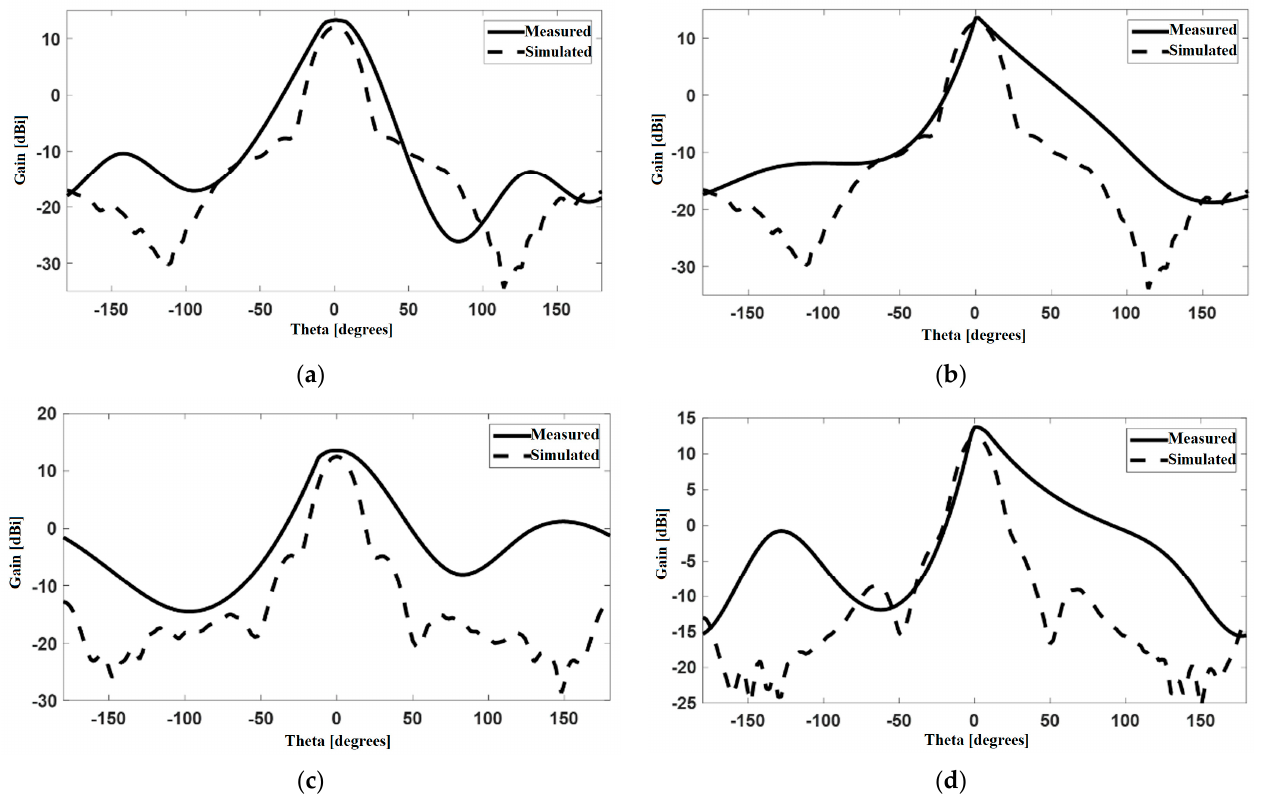
Figure 16. H-plane radiation pattern of the FSS-horn structure at 12 GHz: versions ( a – d ).